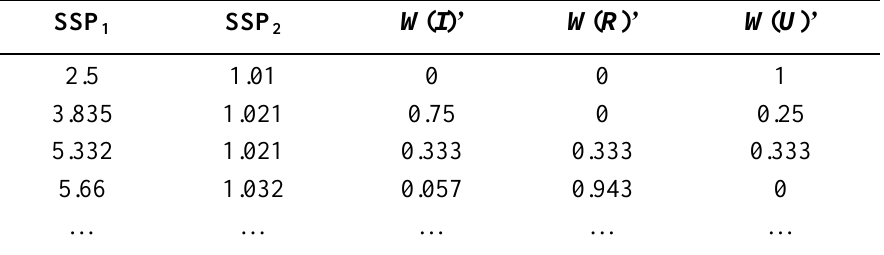
Table 8. Training data for third step of sequential diagnosis.